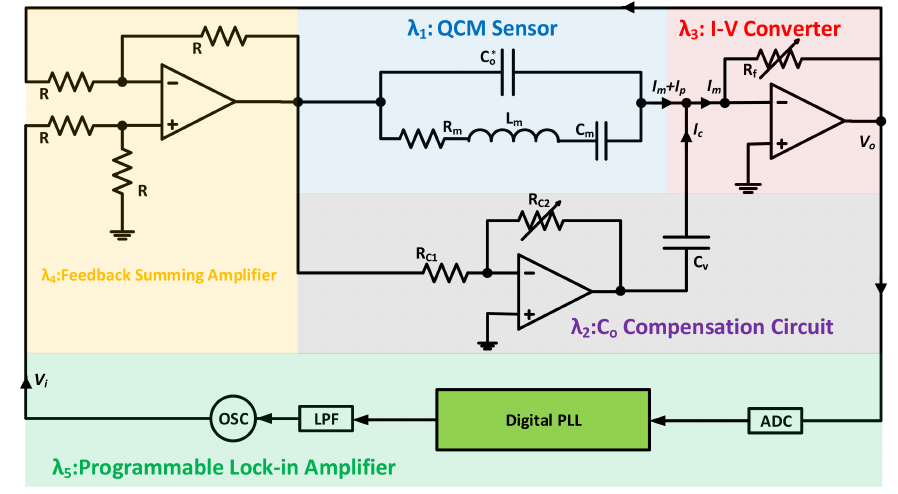
Figure 17. PLL circuit for MSRF tracking with manual Co compensation from